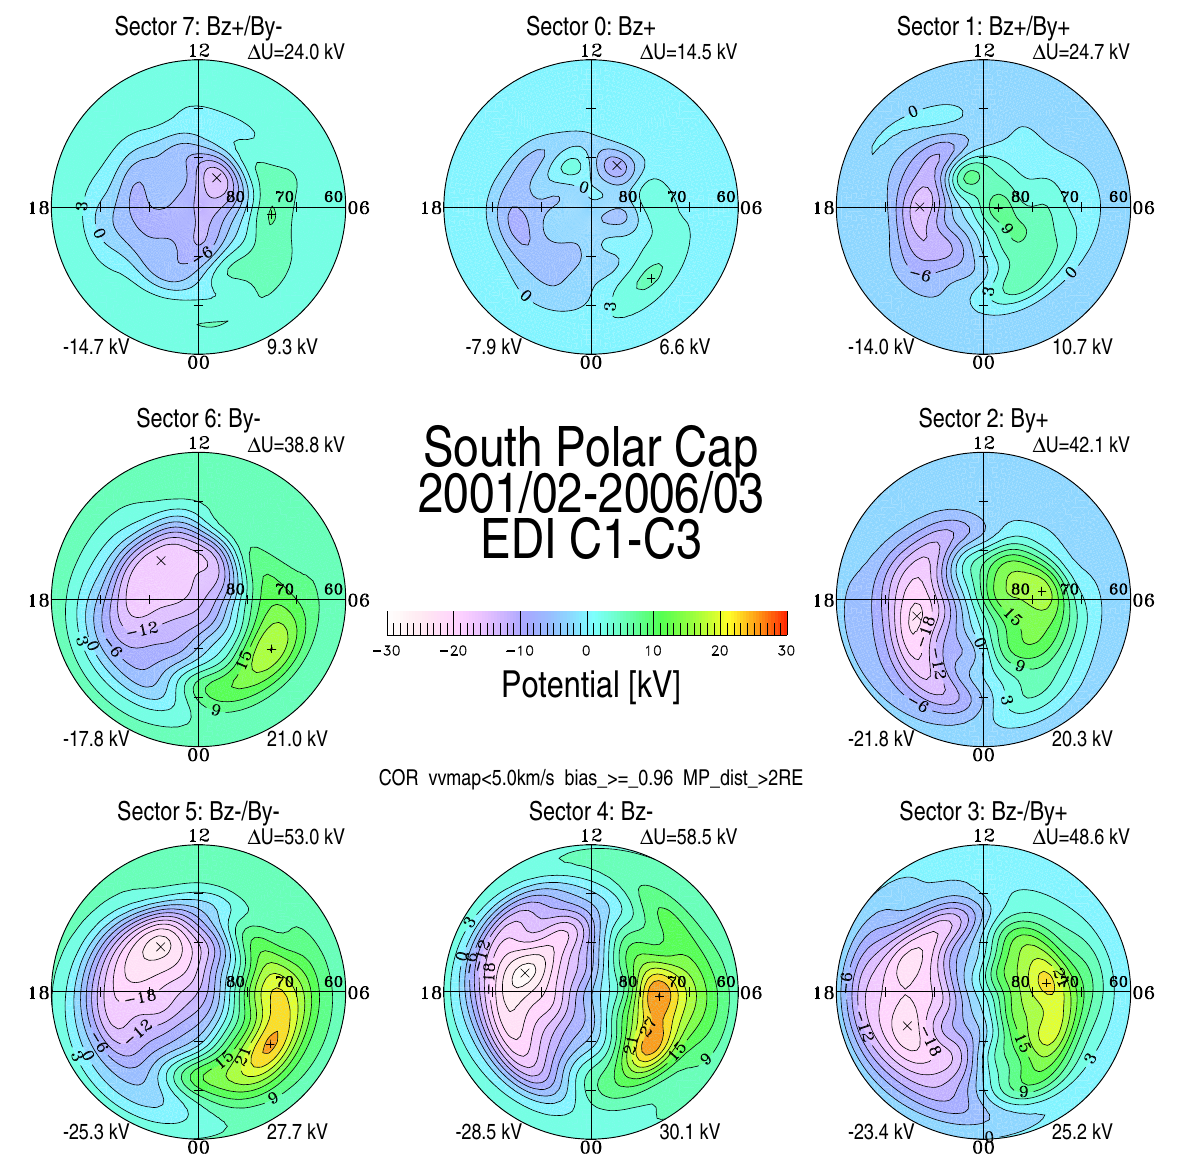
Fig. 8. Same as Figure 7, but for the southern hemisphere. Fig. 8. Same as Fig. 7, but for the Southern